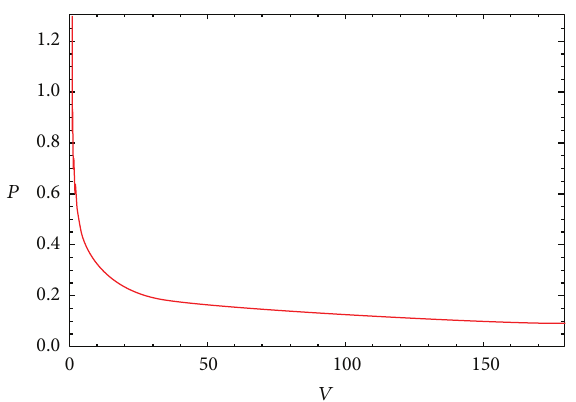
Figure 2: Plots of the pressure 𝑃 versus the volume 𝑉 . The curves correspond to the parameters 𝑇 = 1 , 𝐽 = 0.1 , and 𝑄 = 0.0, 0.5, 1.0 . The three curves roughly